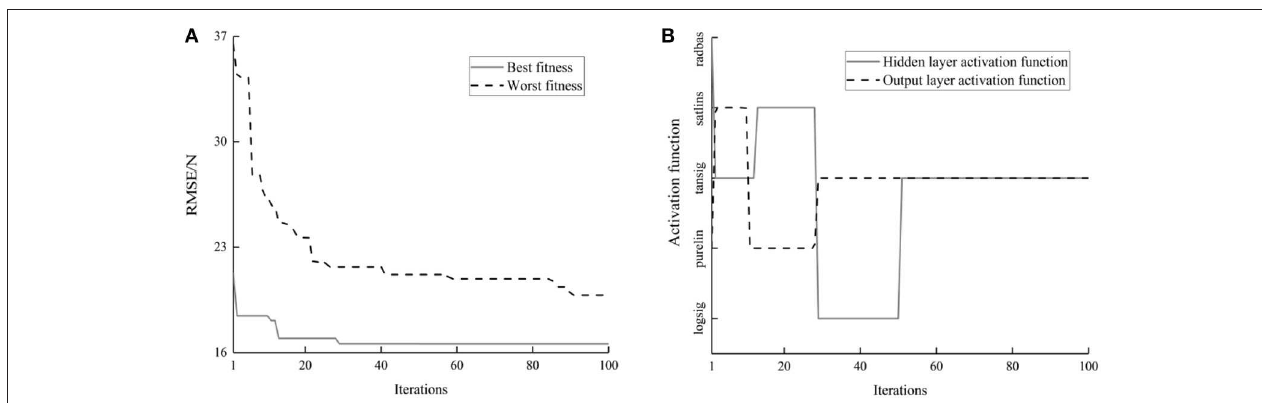
FIGURE 7 | The iteration process of the fitness and activation function in the network model. (A) The fitness. (B) The activation function.